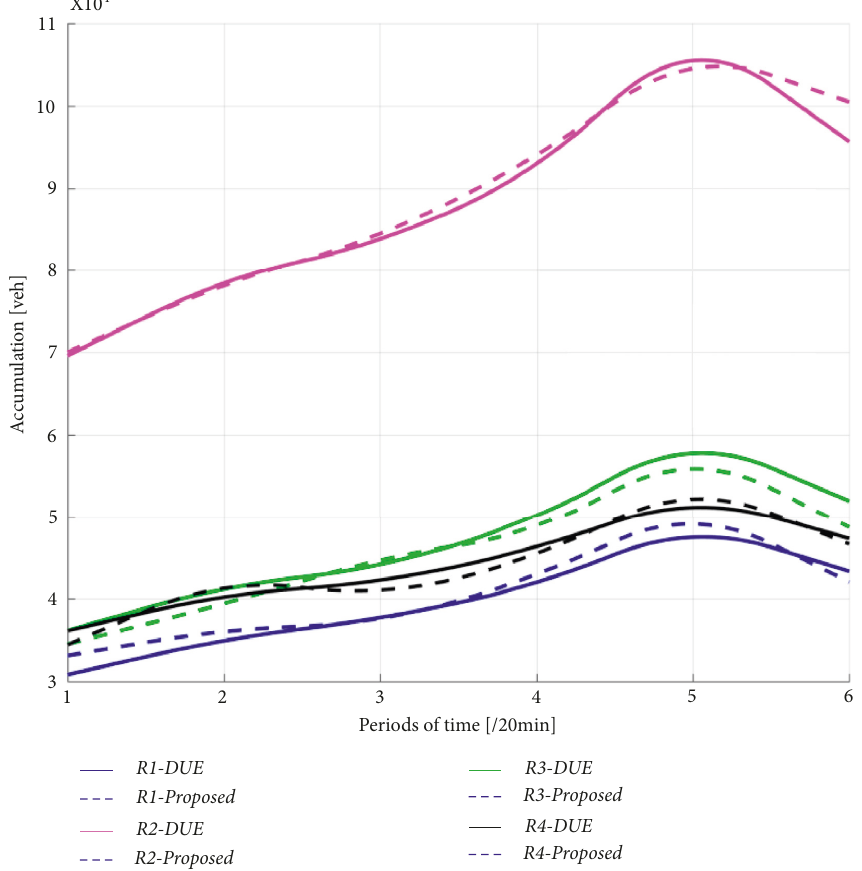
Figure 5: Accumulation of regions with different